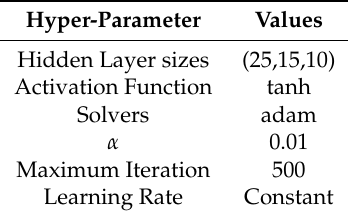
Table 4. Hyper-parameter